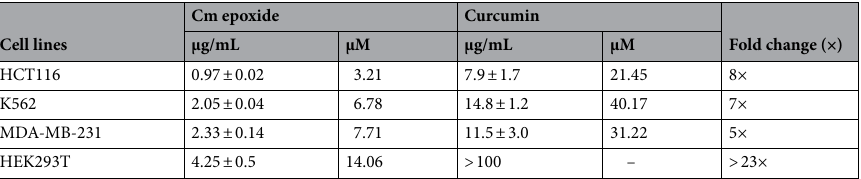
Table 2. IC 50 values obtained with Cm epoxide versus curcumin for 24 h treatment period using different cell lines. Values represent mean ± SD of three experiments; P < 0.05.